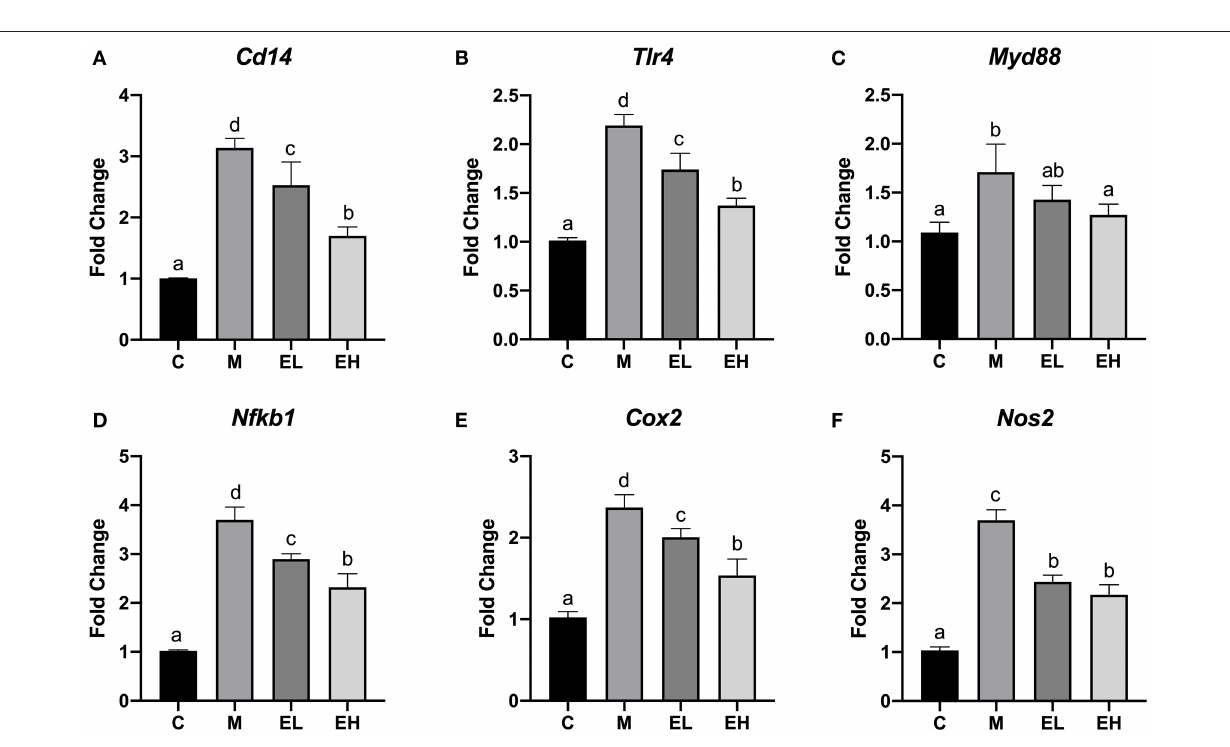
FIGURE 7 | Effect of ellagic acid on the hepatic inflammation associated genes expression in mice. (A) Cd14 ; (B) Tlr4 ; (C) Myd88 ; (D) Nfkb1 ; (E) Cox2 ; (F) Nos2 . Values represent the mean ± SD ( n ≥ 3). Labeled means without a common letter difference. p < 0.05 by one-way ANOVA followed by Duncan’s test. C, normal group; M, model group; EL, low dose of ellagic acid group; EH, high dose of ellagic acid